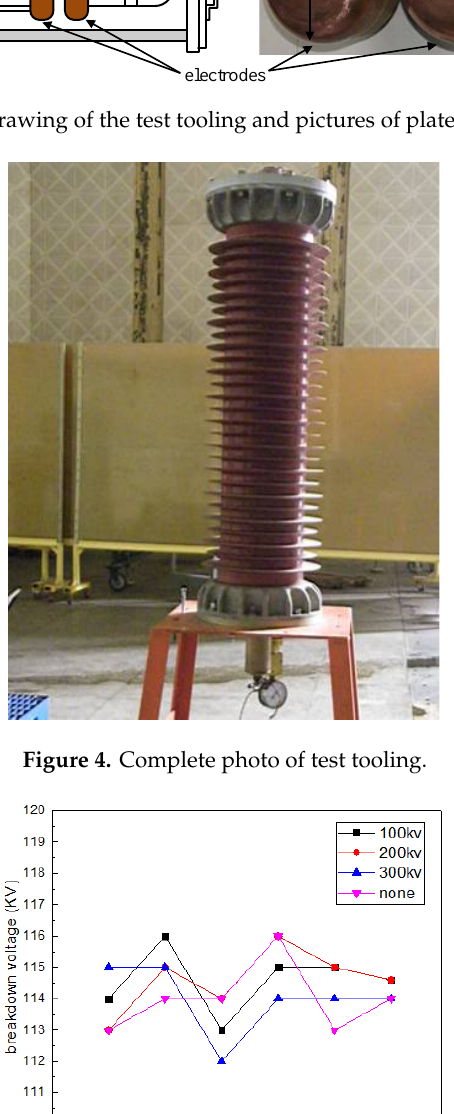
Figure 5. The results of the breakdown voltage.